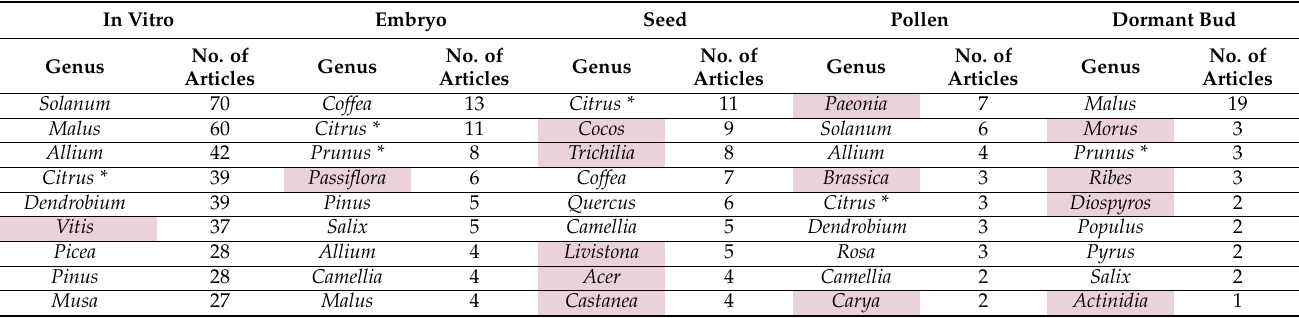
Table 8. Top 25 genera with the most Web of Science articles in each of the five categories of plant cryopreservation